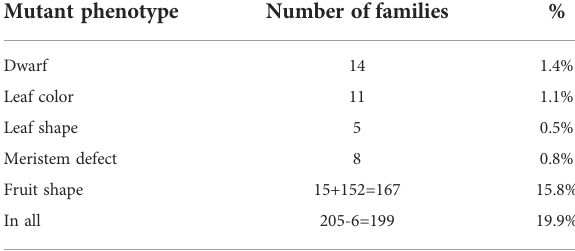
TABLE 3 The mutants of M2